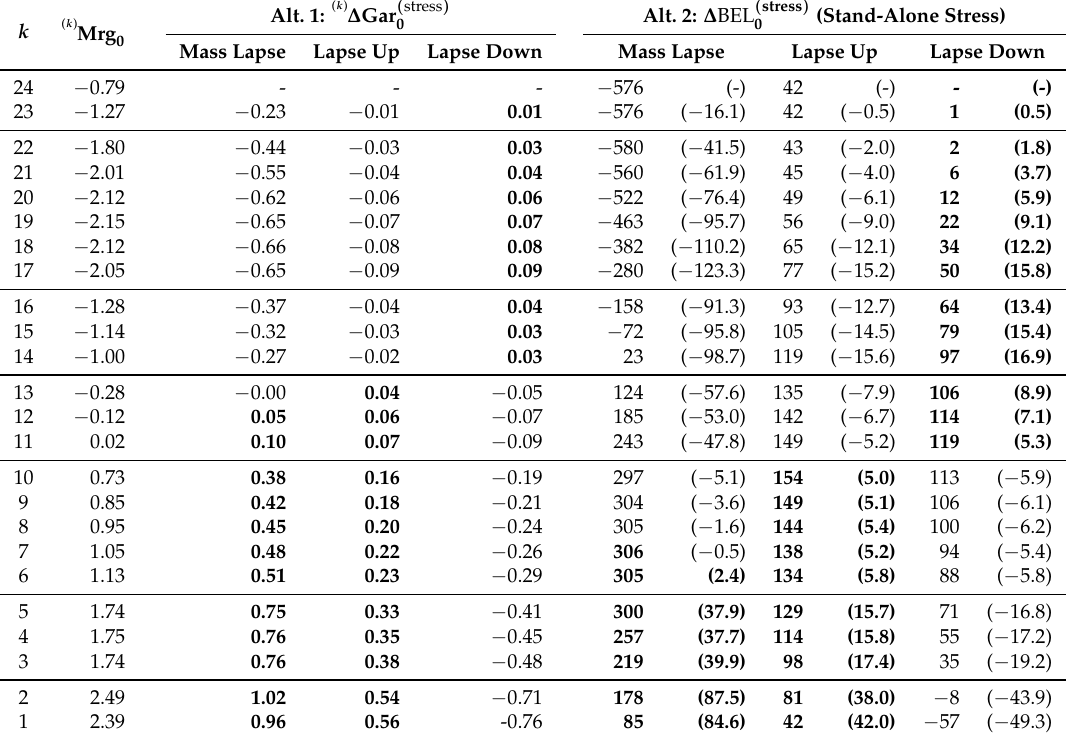
Table 8. Result of segmentation alternatives 1 and 2 (in A